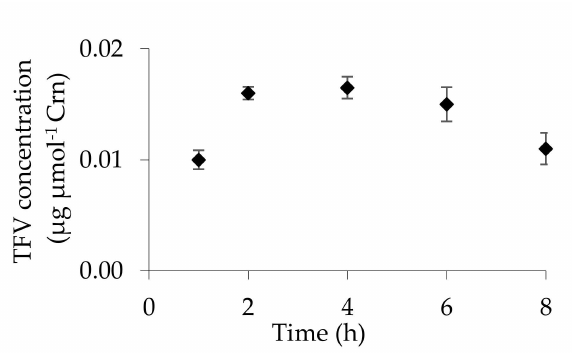
Figure 4. Urinary excretion of TFV after drug intake in dose 123 mg. TFV concentration normalized against Crn; n = 3 for each time